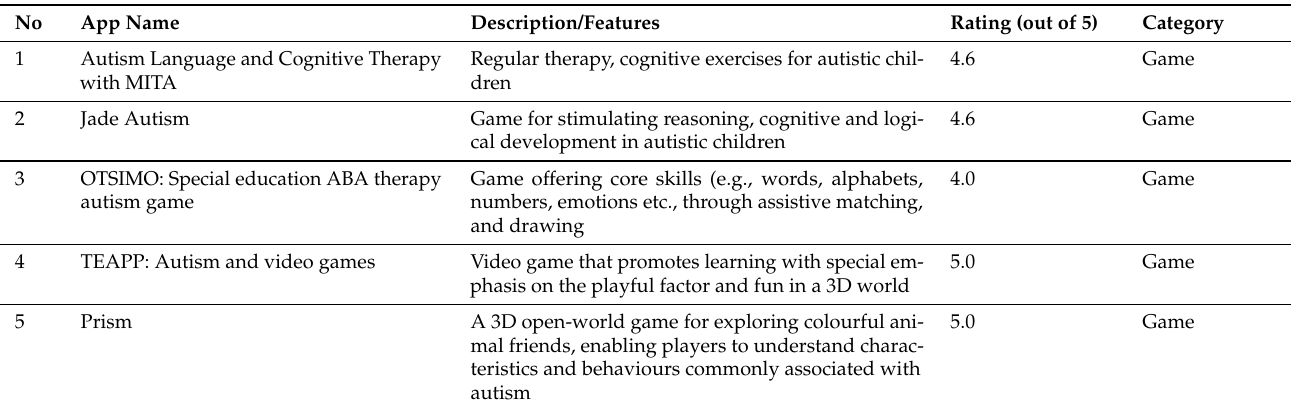
Figure 2. User reviews sentiment analysis. Table 1. List of selected